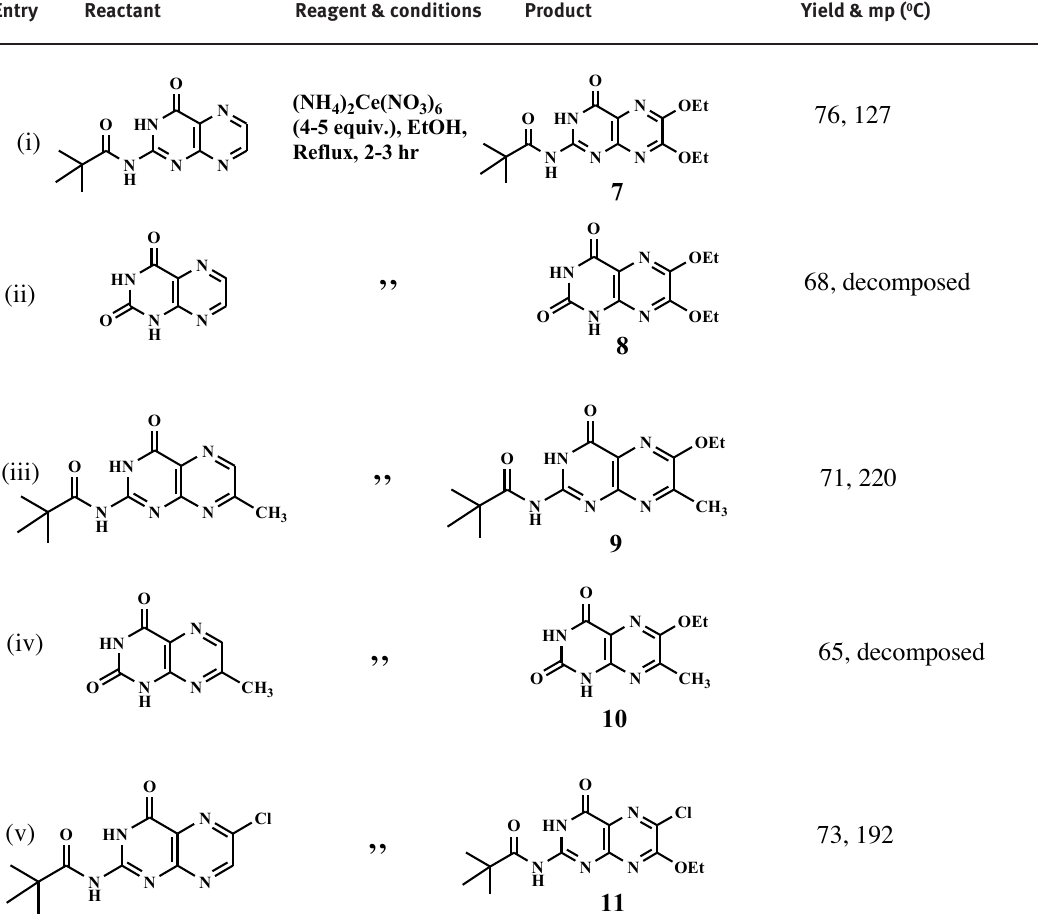
Table 2: Ethoxylation of pterin at 6,7 position using ethanol. Entry Reactant Entry Reactant